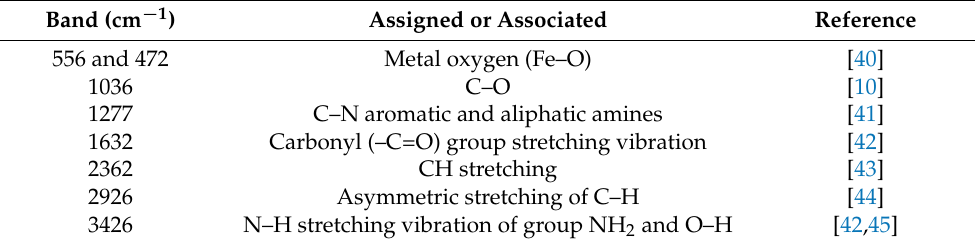
Table 1. Observed bands in Fourier transform infrared analysis and related functional